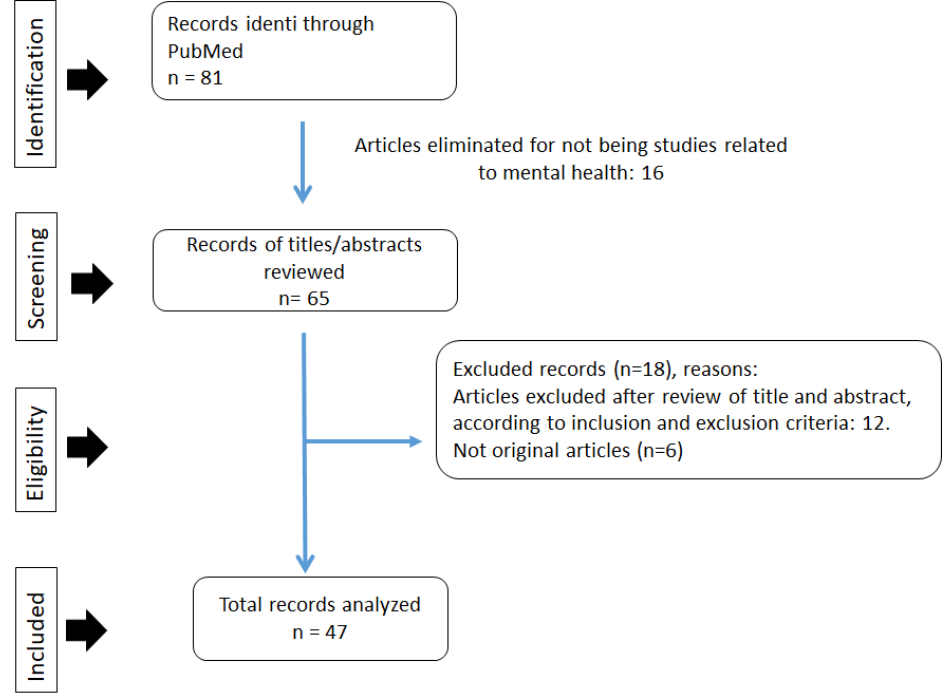
Figure 1. Screening and selection process for the records according to the PRISMA (Preferred Reporting Items for Reviews and Meta ‐ Analyses) flowchart.